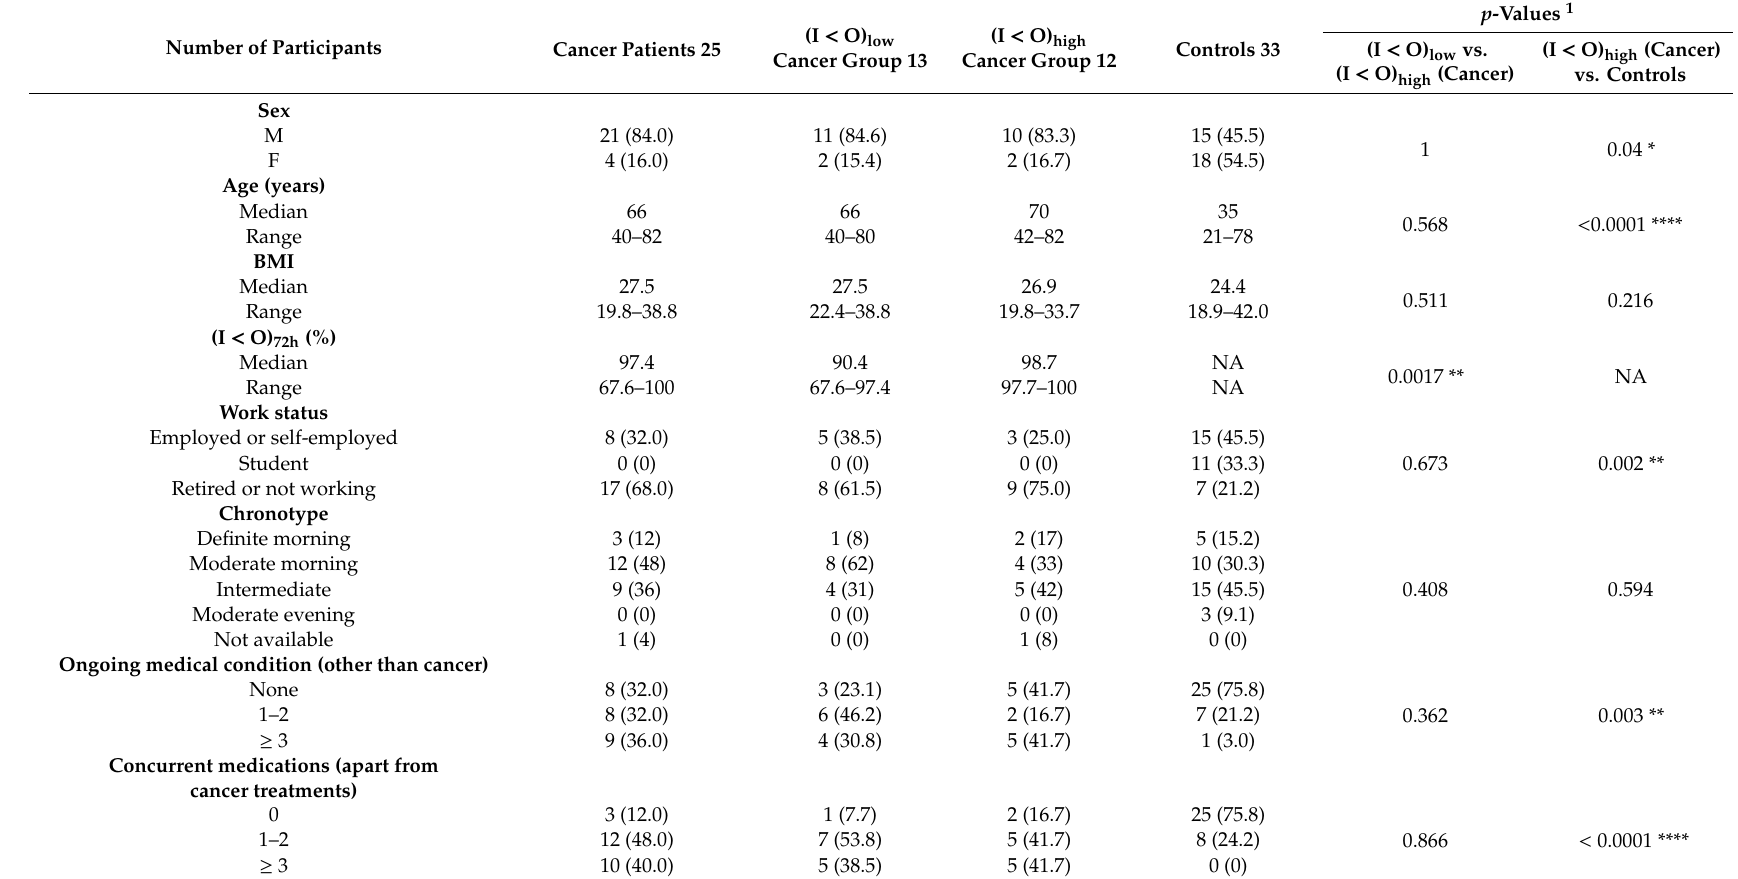
Table 1. Participants’ main characteristics. When not specified the data are presented as Number of subjects